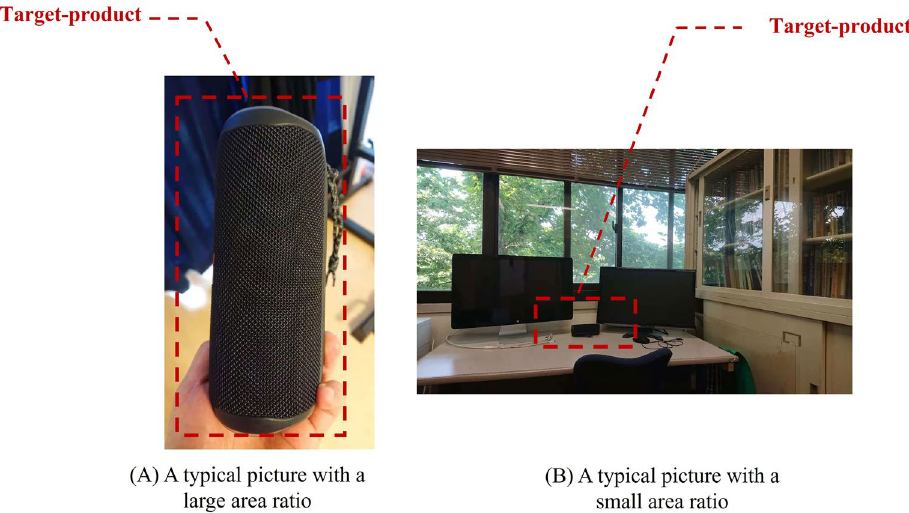
Figure 1. Examples of pictures with different area ratios. (a,b) show two examples with different area ratios. The area ratio in (a) is evidently larger than that in (b) . Therefore, we considered that a participant with a focused attention deployment pattern would submit a picture similar to (a) ; by contrast, a participant with a divided attention deployment pattern would submit a picture similar to (b) . The two pictures used in this figure were taken by the first author. Therefore, these were only used for illustration but not real examples in our two